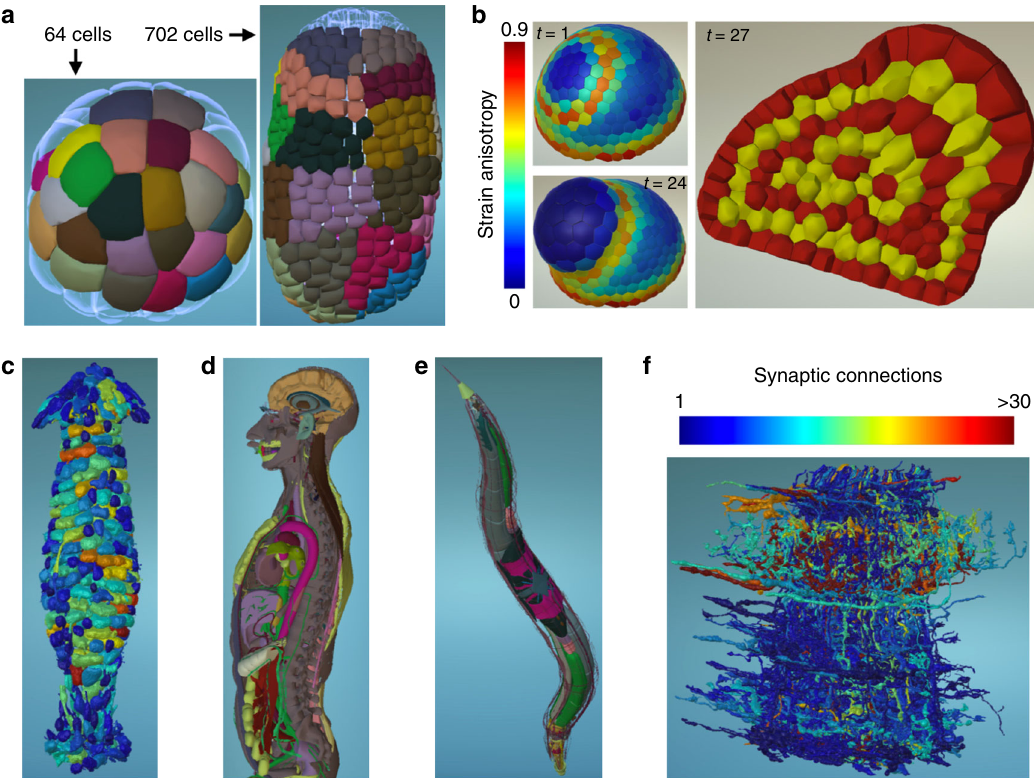
Fig. 2 Morphological datasets and information. a Tracking of epidermal clones through several rounds of cell division in Phallusia mammillata embryo. Epidermal cells are color-coded at 64-cell stage and can hence be followed until 702-cell stage. Published data 7 . b Simulation of an abstract lateral organ formation at an oryzalin-treated shoot apical meristem. Growth is simulated according to Boudon2015 21 , with the wall elasticity model described in Oliveri2018 22 . Strain anisotropy during growth is shown as heatmap for two time points on the left, and inner cell layers are highlighted in alternating red- yellow colors on the right. Data kindly provided by H. Oliveri. c 3D structure of a nest of termite Cubitermes 23 , in which a heat map has been applied to each chamber showing the chambers ’ volume distribution (red = high volume, blue = low volume). Data kindly provided by A. Perna. d Exploration of a human body atlas, in which color labels are applied corresponding to different classes of organs. Dataset can be cut to easily explore its inner structure. e Inner structure of C. elegans worm. To reveal inner organs, hypodermis layers were hidden from view. Color labeling identi fi es different organ groups. f Quantitative information visualization by heat map on Drosophila connectome 6 , representing the distribution of number of synaptic connections for each axon. More information about these datasets can be found in the Supplementary Notes section of the Supplementary Information